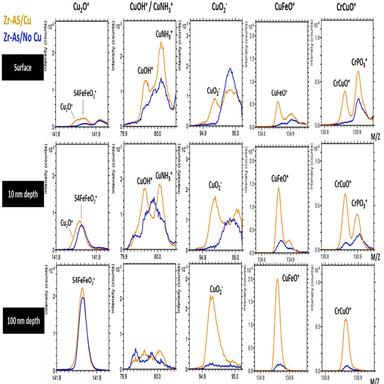
The comparison of the ToF-SIMS depth profile for different Cu-containing fragments at different depths (The peak of 54FeFeO2+ was indicated to consider the overlap of this fragment with Cu2O+).